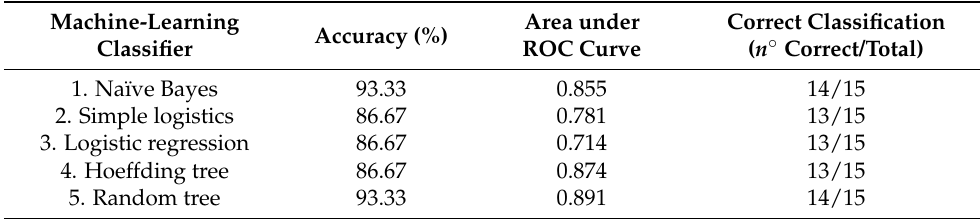
Table 3. Accuracy, area under ROC curve, and number of correct classifications resulting from different machine-learning classifiers, using 10-fold cross validation, for group EMDR ( n = 15) sample assessed